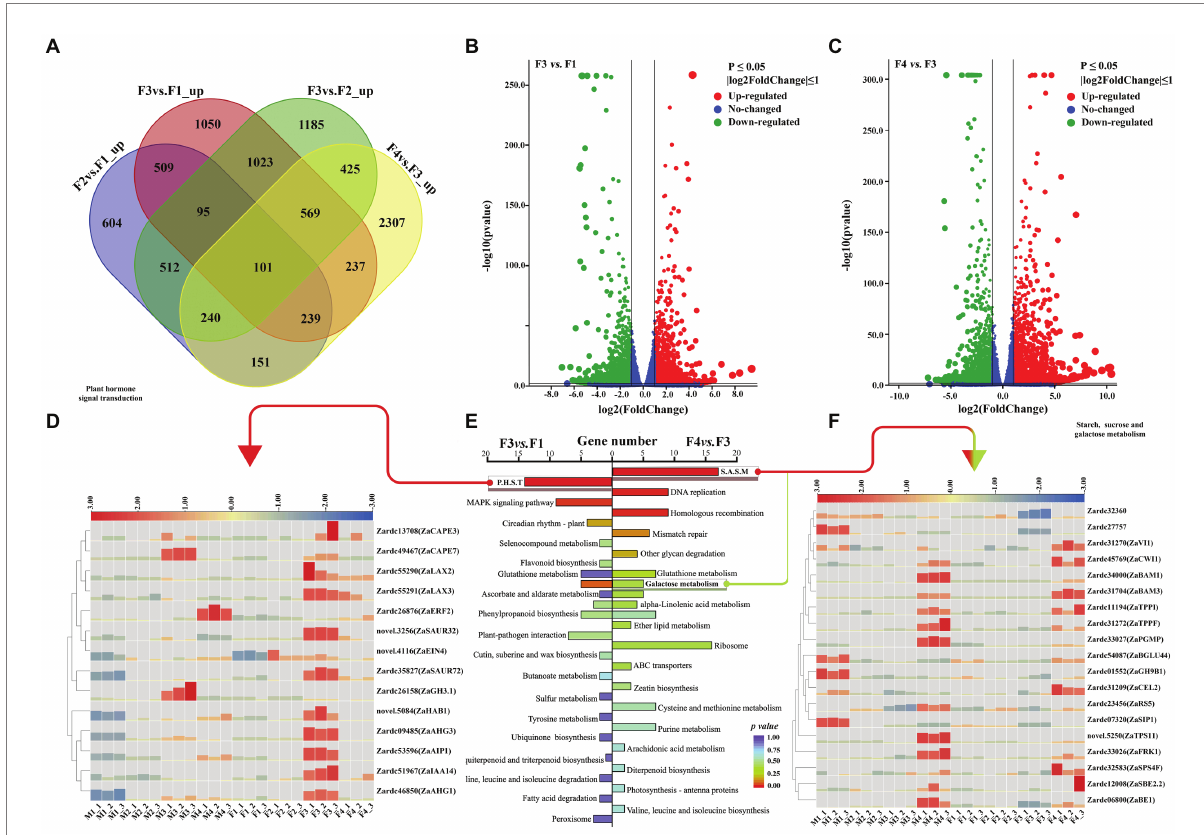
FIGURE 3 The DEGs and significant pathway analysis related to female floral differentiation. (A) The Venn diagram shared with the numbers of up-regulated DEGs in various comparisons of female floral samples. (B) The volcano plot of differential expressed genes (DEGs) in F3 vs. F1. (C) The volcano plot of differential expressed genes (DEGs) in F4 vs. F3. (D) The heat map of the DEGs associated with plant hormone signal transduction which was the significant enrichment pathway in F3 vs. F1. (E) The enrichment pathways in F3 vs. F1 and F4 vs. F3. (F) The heat map of the DEGs related to starch, sucrose and galactose metabolism which was the significant enrichment pathway in F4 vs.